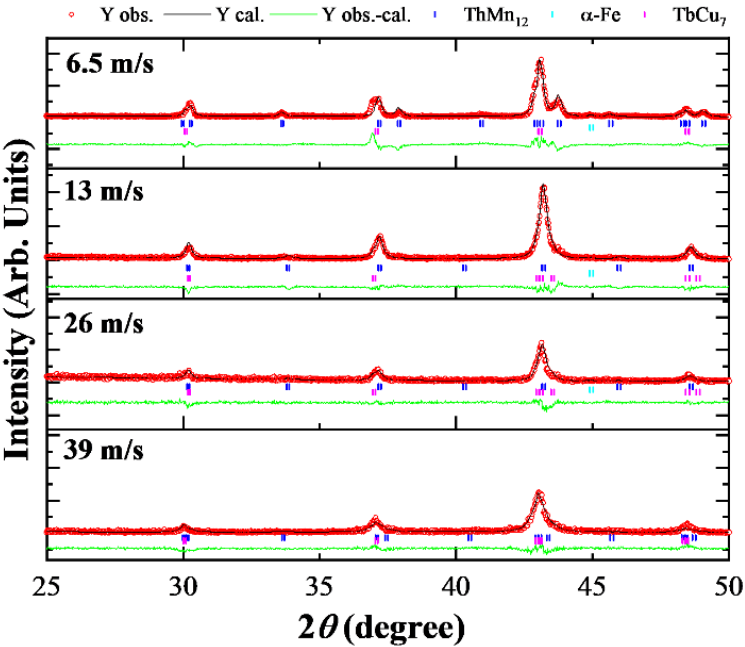
wheel speed, correspond to the decreasing grain sizes of the crystallized ThMn 12 -type and TbCu 7- type phases. Lattice parameters a and c of ThMn 12 -type and TbCu 7 -type phases in the samples with different wheel speeds are also listed in Table 1. The increase in wheel speed from 6.5 to 39 m/s led to the change in lattice parameters. The parameters a and c of ThMn 12 -type and TbCu 7 -type change irregularly when the wheel speed increase from 6.5 to 39 m/s. However, for the 26 m/s melt-spun ribbons, the c/a of ThMn 12 -type gets the highest point of 0.5571 while the c/a of TbCu 7 -type gets the lowest point of 0.8546. The calculated average atomic volumes of ThMn 12 -type and TbCu 7 -type increased linearly due to increased cell volumes when the solidification rate increased.